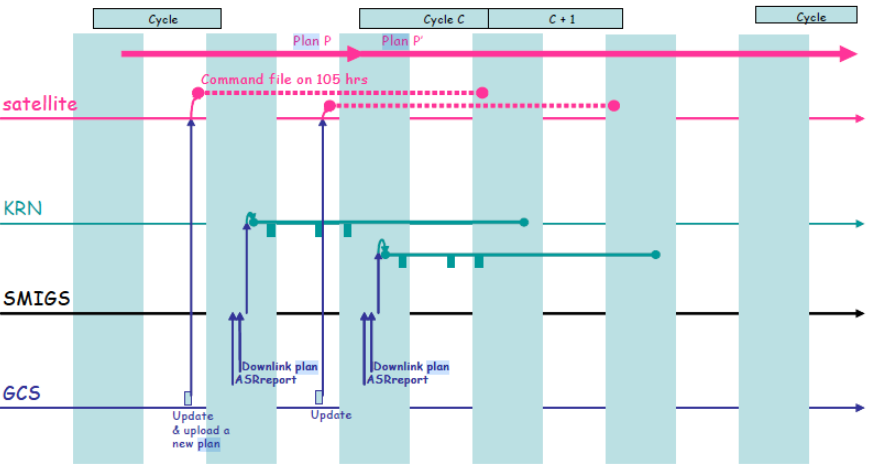
Figure 36. Maintaining the programming.